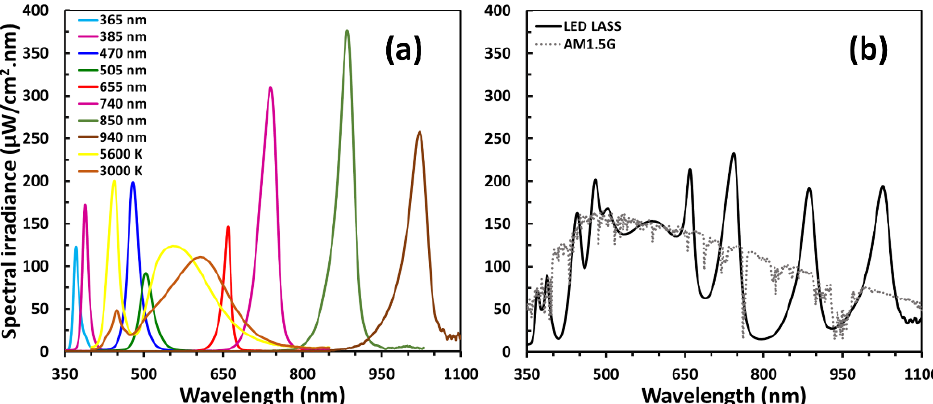
Figure 1. ( a ) The spectral irradiance of the 10 individual LED types (365 nm, 385 nm, 470 nm, 505 nm, 655 nm, 740 nm, 850 nm, 940 nm, 5600 K, and 3000 K), each with unique spectral profile. ( b ) The spectral irradiance of the Sun AM1.5G (gray) set against the synthetic spectrum of the LED LASS (black).